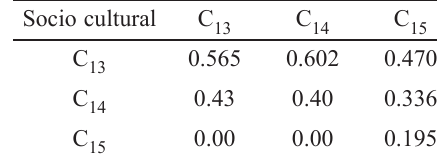
Table 9. The relative importance weights for criteria under the Socio Cultural